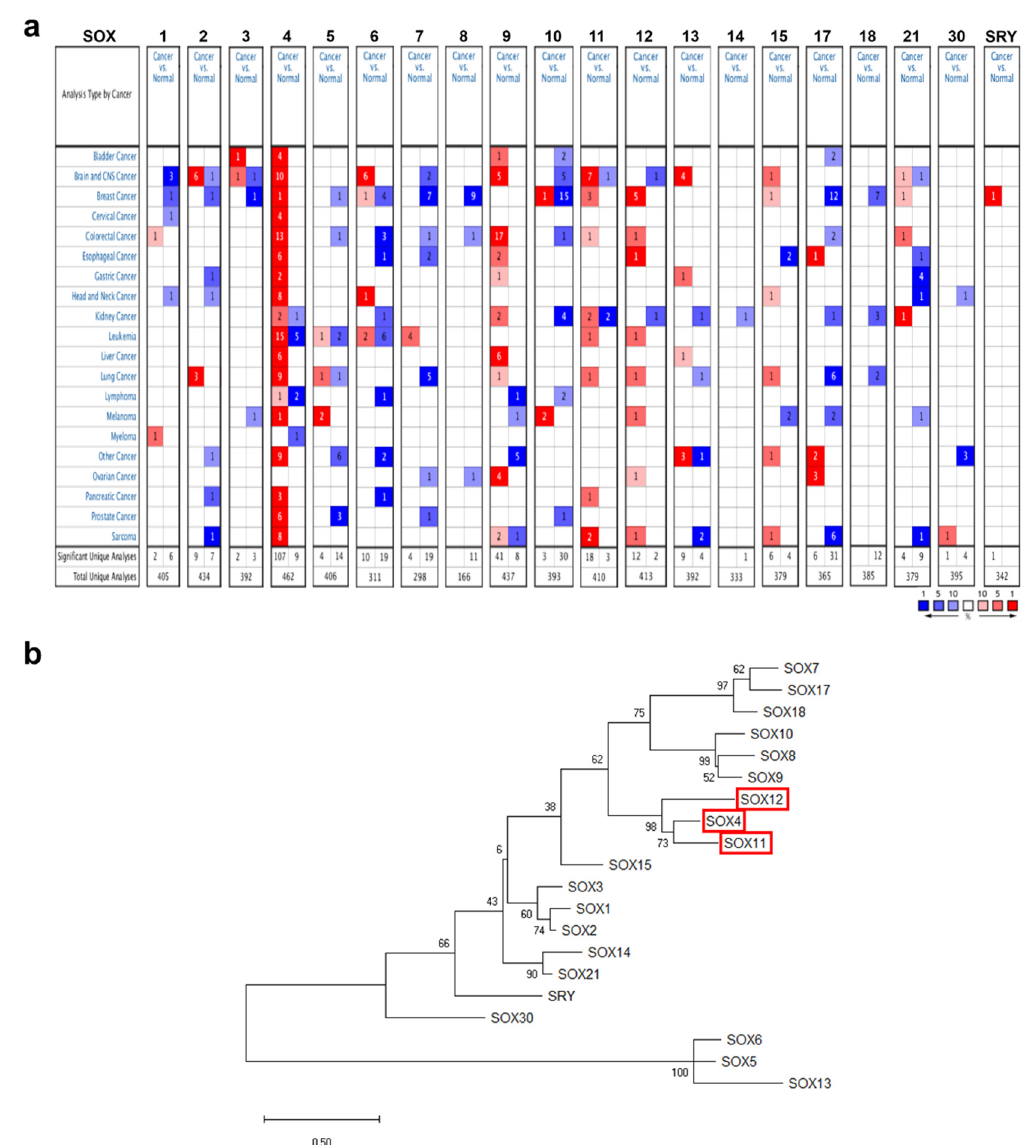
Figure 1. mRNA expression levels of the SOX gene family in different cancer types. ( a ) Comparison of the expression of SOX gene family members from the Oncomine database, indicating the number of datasets with mRNA overexpression (red) or underexpression (blue), between various types of cancers and their normal counterparts. The threshold was determined based on the following parameters: p -value < 0.001, fold-change of 2, and gene ranking of 10%. ( b ) Phylogenetic tree analysis of the SOX gene family proteins was performed using the Molecular Evolutionary Genetic Analysis (MEGA) tool. The tree was derived from the maximum likelihood method.